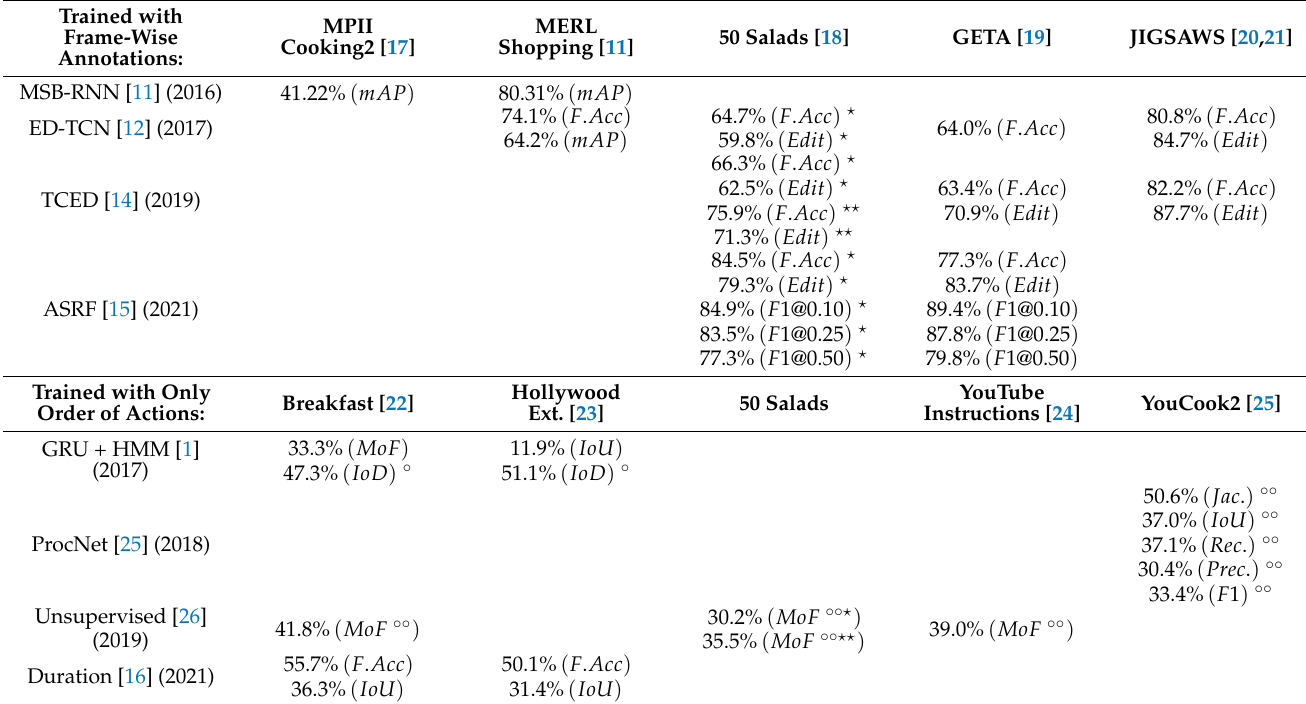
Table 1. State-of-the-art performance under different training